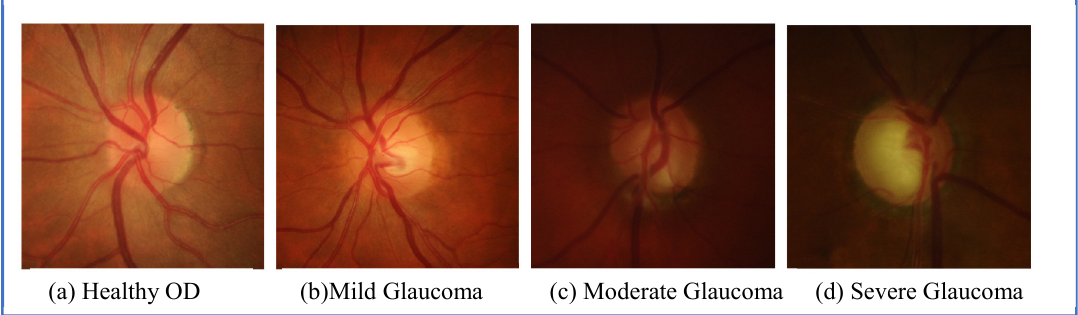
Figure 2. Grading of glaucoma diseases: ( a ) healthy OD; ( b ) Mild Glaucoma; ( c ) Moderate Glaucoma and ( d ) severe glaucoma.